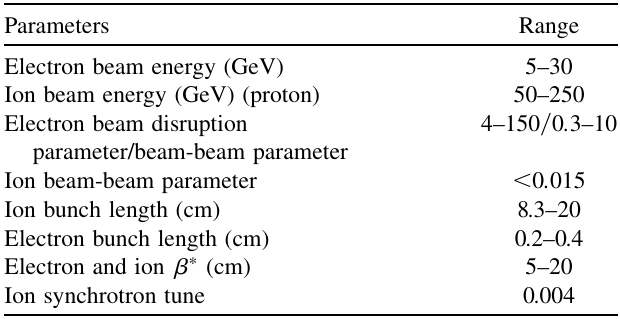
TABLE I. eRHIC parameter range of